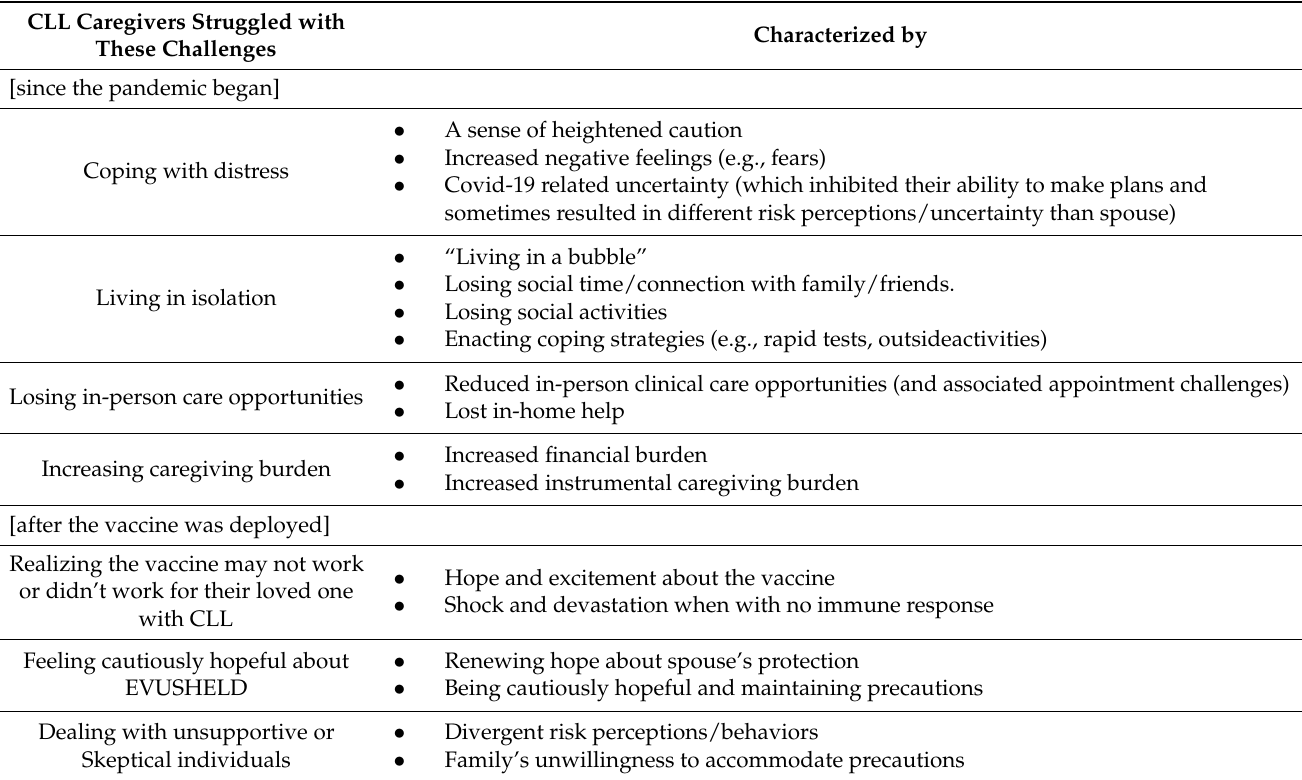
Table 1. Challenges Encountered by CLL Caregivers During the COVID-19 Pandemic.